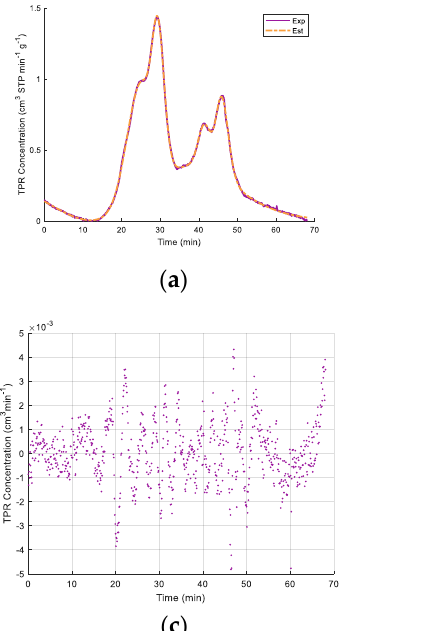
Figure A3. Deconvolution of the TPR plot with 650 °C as maximum temperature, for a regenerated 4% Fe/10% CaO- γ-Al 2 O 3 catalyst sample. Deconvolution of the TPR plot, with 650 °C as maximum temperature for a regenerated 4% Fe/10% CaO- γ-Al 2 O 3 catalyst sample: ( a ) adjustment curve with R 2 = 0.9995, ( b ) composition curves, ( c ) regression residues, ( d ) probability distribution of the adjustment curve selected.